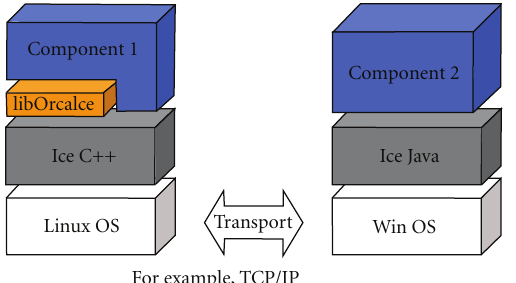
Figure 6: Two Orca components acting as a server or a client. (© (2006) IEEE), (reproduced from [43] with permission of Dr. Alexei